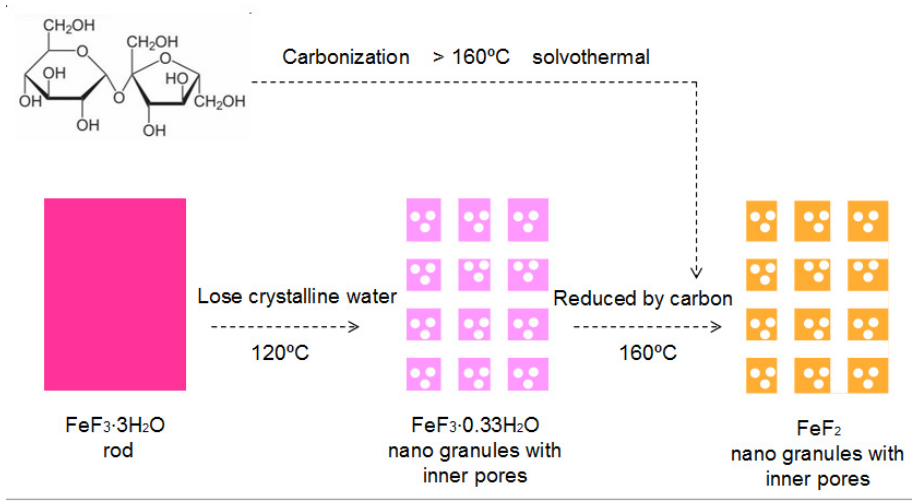
Figure 3. Schematic illustration of the transformation process from the FeF 3 ∙ 3H 2 O precursor, to the intermediate product FeF 3 ∙ 0.33H 2 O, and to FeF 2 sample.